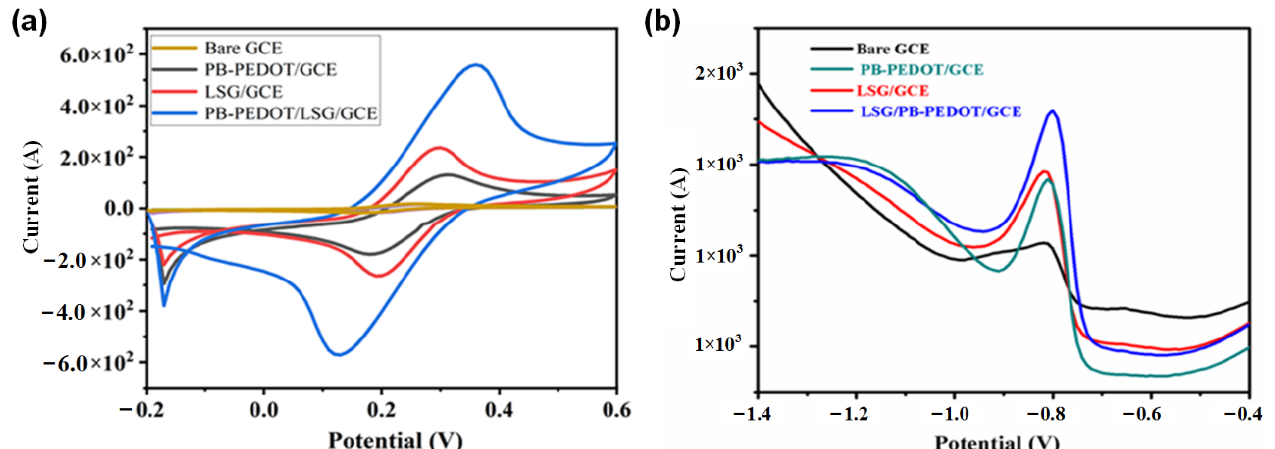
Figure 3. ( a ) CV curves of all the modified electrodes in 0.1 M KCl containing 1 mM K 4 Fe (CN) 6 redox couple at 50 mV scan rate; ( b ) comparative DPV curves of all the modified electrodes in 500 µM of Cd 2+ .